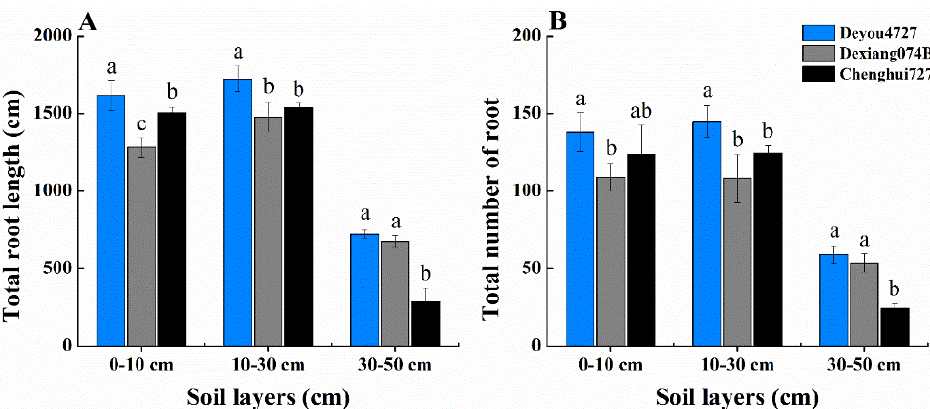
Figure 2. The root distribution of the total root length ( A ) and total number of roots ( B ) in different soil layers of Deyou4727 and its parents. The values in each graph represent the Mean ± SE (standard error) of 3–6 replicates, and lowercase letters indicate significant differences between varieties and treatments, at p < 0.05.